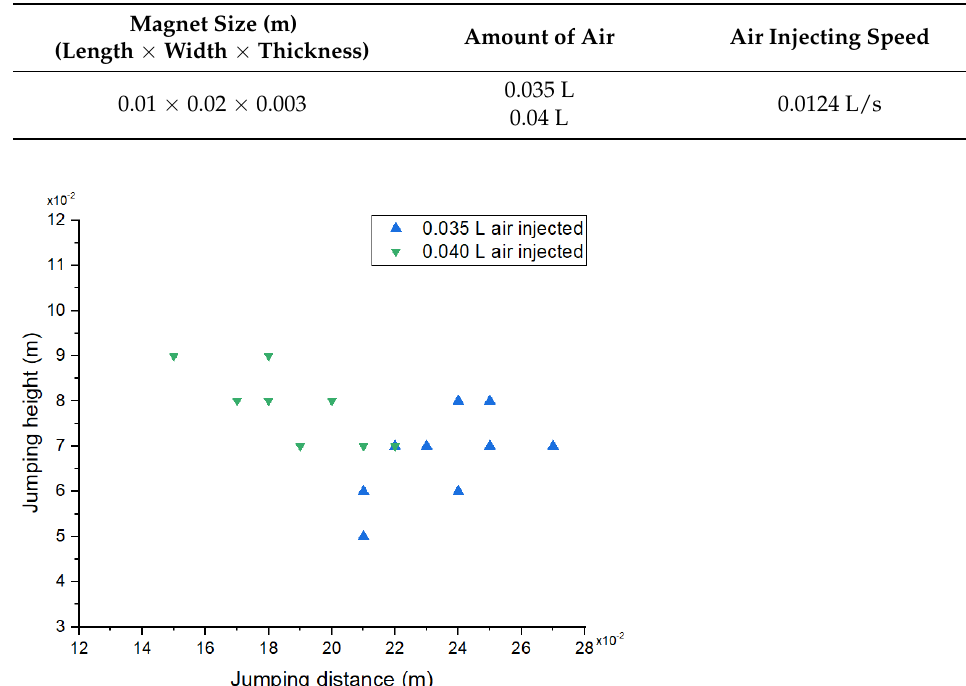
Figure 19. Result of comparison of the jump forces depending on the volume of air injected test.